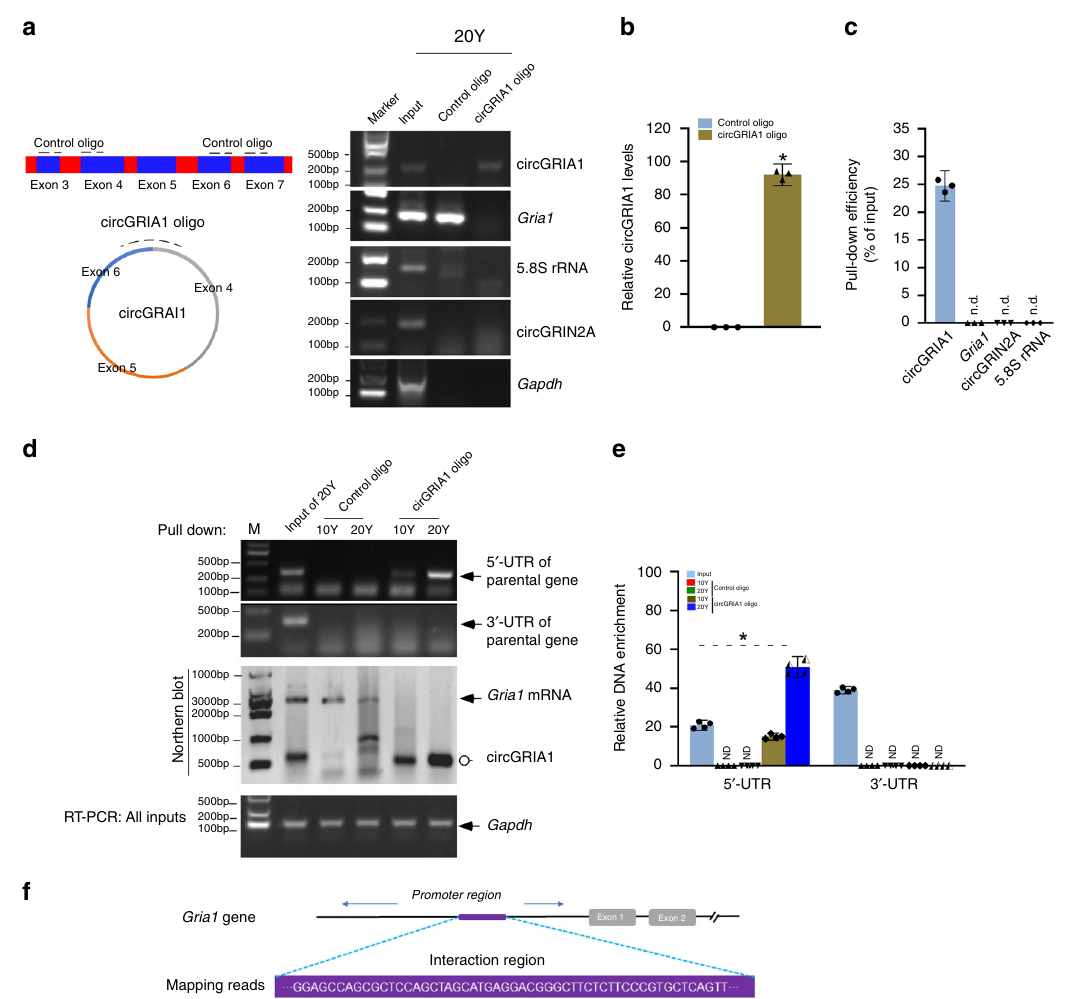
Fig. 3 The regulatory effect of circGRIA1 on the parental genomic locus. a Biotin-labeled oligonucleotides (oligos) complementary to the junction sequences of circGRIA1 were used for Chromatin Isolation by RNA puri fi cation (CHIRP). Oligos complementary to upstream and downstream exons were used as control. Total RNA was extracted from postmortem frozen hippocampal tissues of 20-Y male macaque . The images are representative of three independent experiments of each sample from 2 to 3 animals per age group. b , c Quanti fi cation of three repetitions of independent experiment in ( a ) showed the CHIRP ef fi ciency of circGRIA1. Pre-mRNA of Gria1 was not detected (n. d.) in the CHIRP products as examined with primer pairs corresponding to the parental gene. Both circGRIN2A and 5.8S rRNA were used as controls. Black dash curves represent circRNA junction-targeting (curve) and -nontargeting (linear) sequences of biotin-labeled oligos. d CircGRIA1 interacts with the promoter of its parental gene. Total RNA was extracted from postmortem frozen hippocampal tissues of 10- and 20-year-old male macaques . Upper panel shows PCR products of the parental gene 5 ′ -UTR and 3 ′ -UTR regions against circGRIA1 oligos in ChIRP. Middle panel shows northern blot of Gria1 mRNA and circGRIA1 in the product of CHIRP with digoxin-labeled probes. Semi-quantitative RT-PCR of Gapdh was a loading control. e Quanti fi cation of three repetitions of independent experiment in ( d ). Data represents mean ± S.D.; * p < 0.01, unpaired t -test. f The alignment of circGRIA1-associating motif and the promoter region of its host mRNA gene. A schematic representation of the promoter structure is shown at the top. The gene is coded on the negative strand. The arrows indicate the sanger sequencing data of semi-quantitative RT-PCR products of circGRIA1 parental gene 5 ′ -UTR from CHIRP consistent with the coding sequences. Source data are provided as a Source Data fi le. NMDA ( N -methyl- D -aspartate) receptors-mediated neuronal junction site-targeting siRNAs against circGRIA1 or the mis- activity 35 . Changes in the mini excitatory postsynaptic currents matched junction site-targeting siRNA-control. We then tracked (mEPSCs) are used to model this activity as their levels are the effects of this manipulation on the mEPSCs at different times dependent on the number of synapses formed and/or the pre- after infection. Both the amplitude and frequency of spontaneous synaptic rate of vesicle release. At equilibrium, mEPSCs ampli- mEPSCs showed the normal decreases in control cultures tude is dependent on either postsynaptic glutamate responsiveness or a presynaptic glutamate content of synaptic vesicles or both. Since circGRIA1 not only affects GluR1 expression, but also regulates the densities of presynaptic com- receptor blockade-induced change by manipulating neuronal ponent synapsin-I, we were curious whether circGRIA1 con- tributed to homeostatic synaptic plasticity. Hippocampal cultures ment. At DIV28, bicuculline enhanced excitatory neural activity, of fetal macaques were prepared, then infected on DIV5 with the NATURE COMMUNICATIONS| (2020) 11:3594